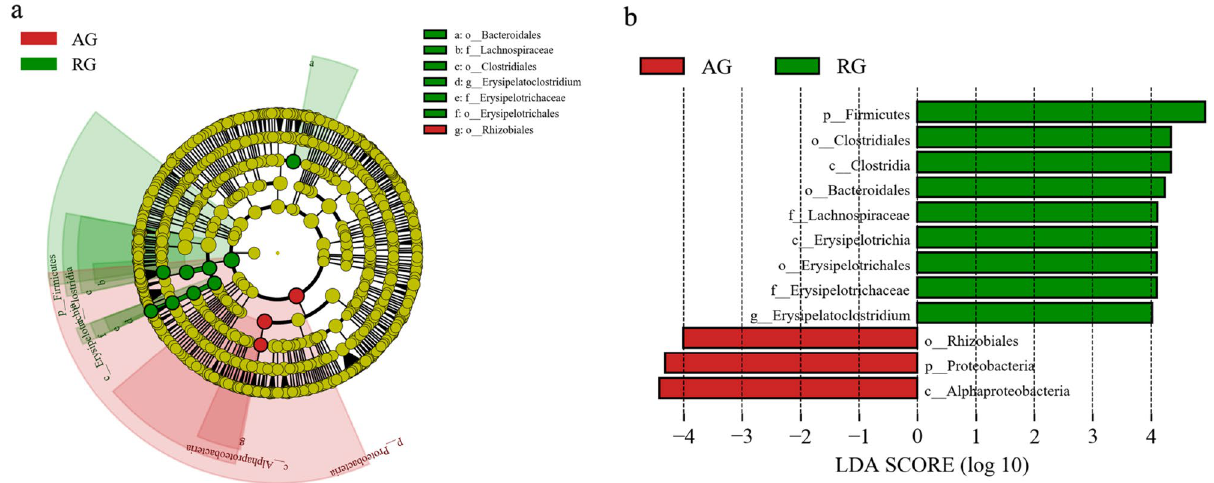
Figure 4. LEfse analysis of bacteria characterictic taxa in two gyms. ( a ) (from phylum to genus) cladogram; ( b ) bar diagram. The bacterial biomarker enriched in AG (red) in cladogram ( a ) is Rhizobiales. Similarly, as shown in the cladogram, the bacterial biomarkers of RG (green) in column figure ( b ) are Erysipelatoclostridium , and Lachnospiraceae and Bacteroidales. The node size in FIG.4.a represents the abundance of the group. b Histogram shows LDA score > 3 and p <